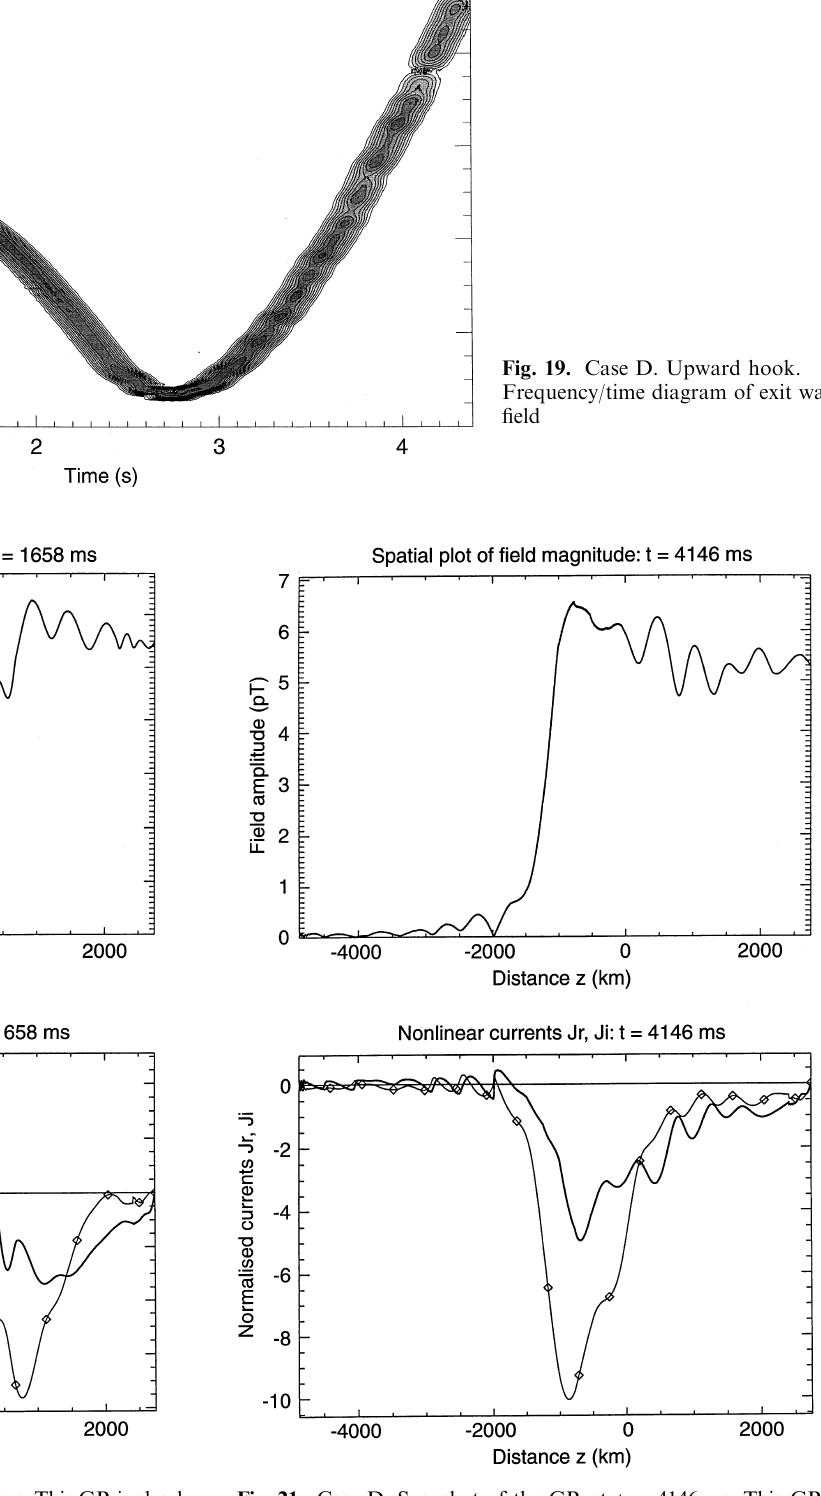
Fig. 20. Case D. Snapshot of GR at t = 1658 ms. This GR is clearly of the faller type